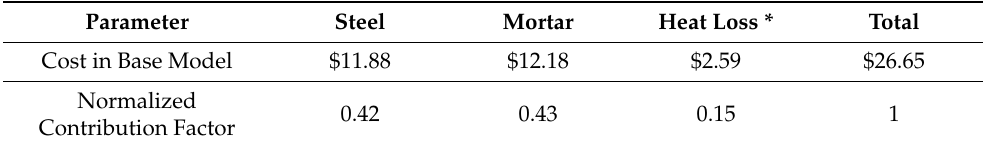
Table 4. Estimation of Weight Factors used in this Study. Parameter Steel